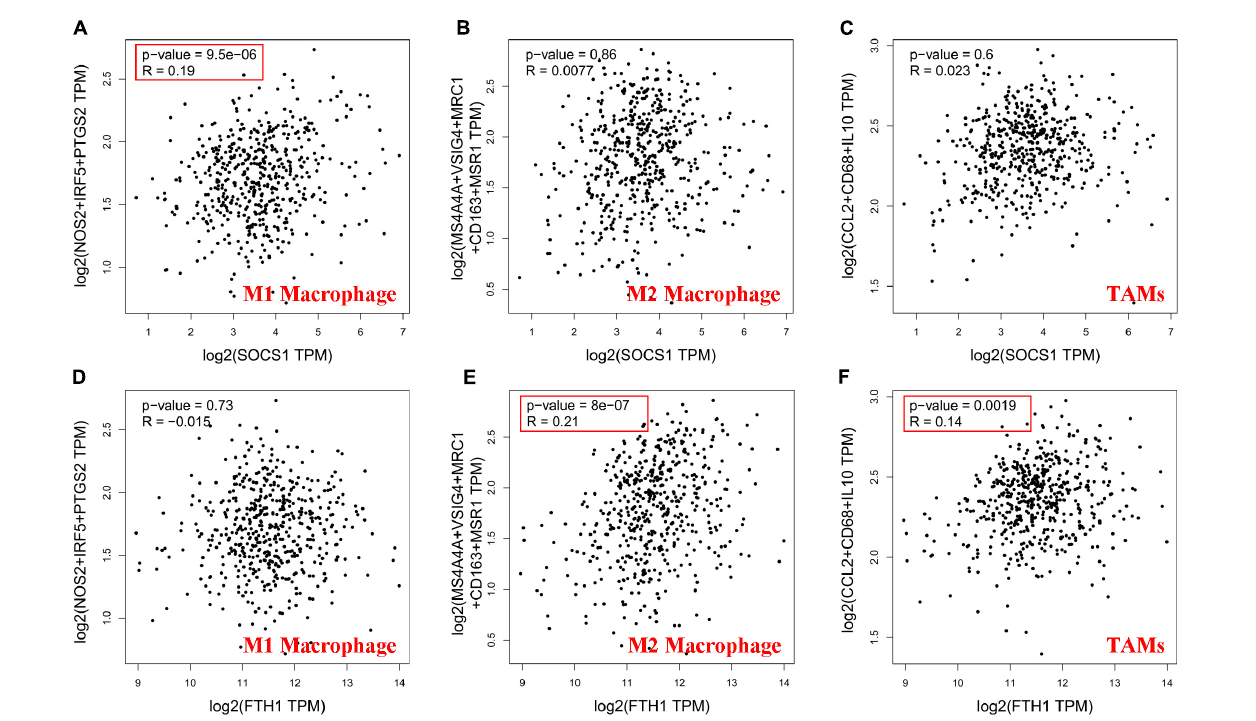
FIGURE 6 | Significance of the correlations between SOCS1 and FTH1 expression and markers of macrophages (GEPIA2). (A) SOCS1 and M1 ( R = 0.19, p = 9.5 × 10 − 6 ). (B) SOCS1 and M2 ( R = 0.0077, p = 0.86). (C) SOCS1 and TAMs ( R = 0.023, p = 0.6). (D) FTH1 and M1 ( R = –0.015, p = 0.73). (E) FTH1 and M2 ( R = 0.21, p = 8 × 10 − 7 ). (F) FTH1 and TAMs ( R = 0.14, p = 1.9 × 10 − 3